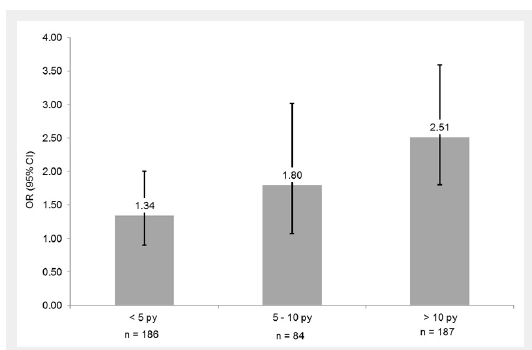
Relationship of pre-diabetes with cumulative smoking exposure. Never smokers represent the reference group. Boxes indicate odds ratios, whiskers are 95% confidence intervals. Data are adjusted for age, sex, Body Mass Index, hypertension, alcohol consumption, education, low density lipoprotein and high density lipoprotein cholesterol, physical activity, fruit/vegetable consumption and body